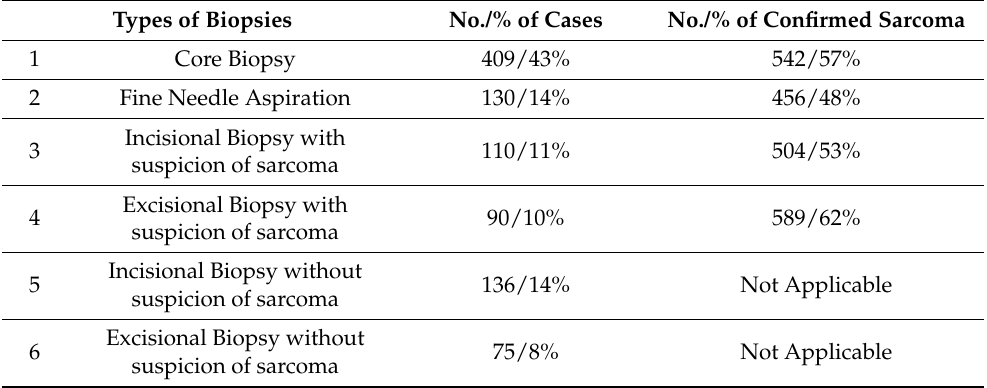
Table 2. Types of biopsies performed; n =